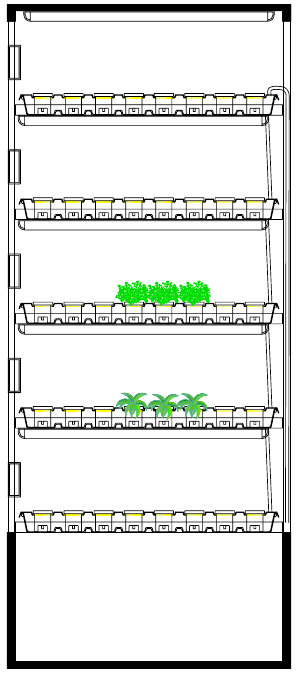
Figure 1. Placement of basil and lettuce in the vertical farms.